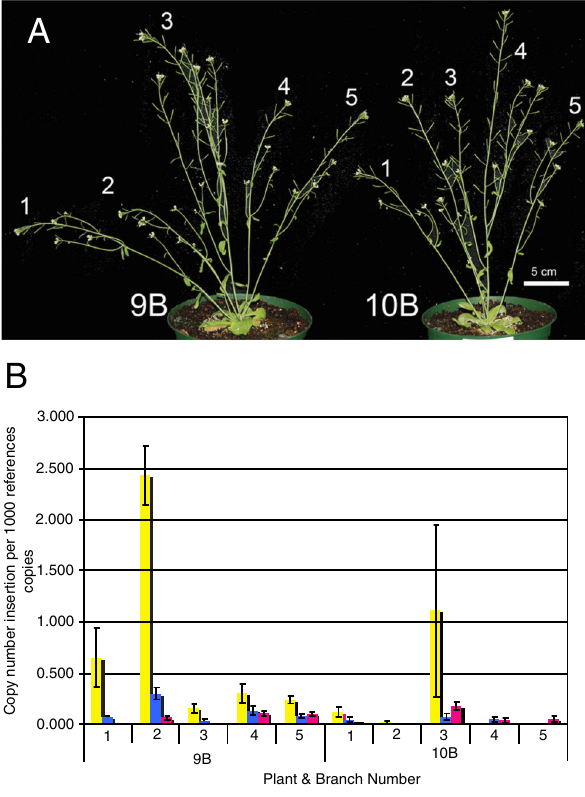
Figure 6. Relative genomic copy number of insertion sequences in two wild type plants. ( A ) DNA was extracted from branches 1–5 of two wt hybrid plants (9B and 10B) and amplified using qPCR. ( B ) Graphical representation of qPCR results using three different indel markers ((F15H11 (yellow), T14G11 (blue), and MGI19 (pink)). Colored bars show the number of insertion sequences per 1000 copies of the reference sequence (lines indicate standard error of the mean, n=3). Novel insertion sequences could be detected in all 10